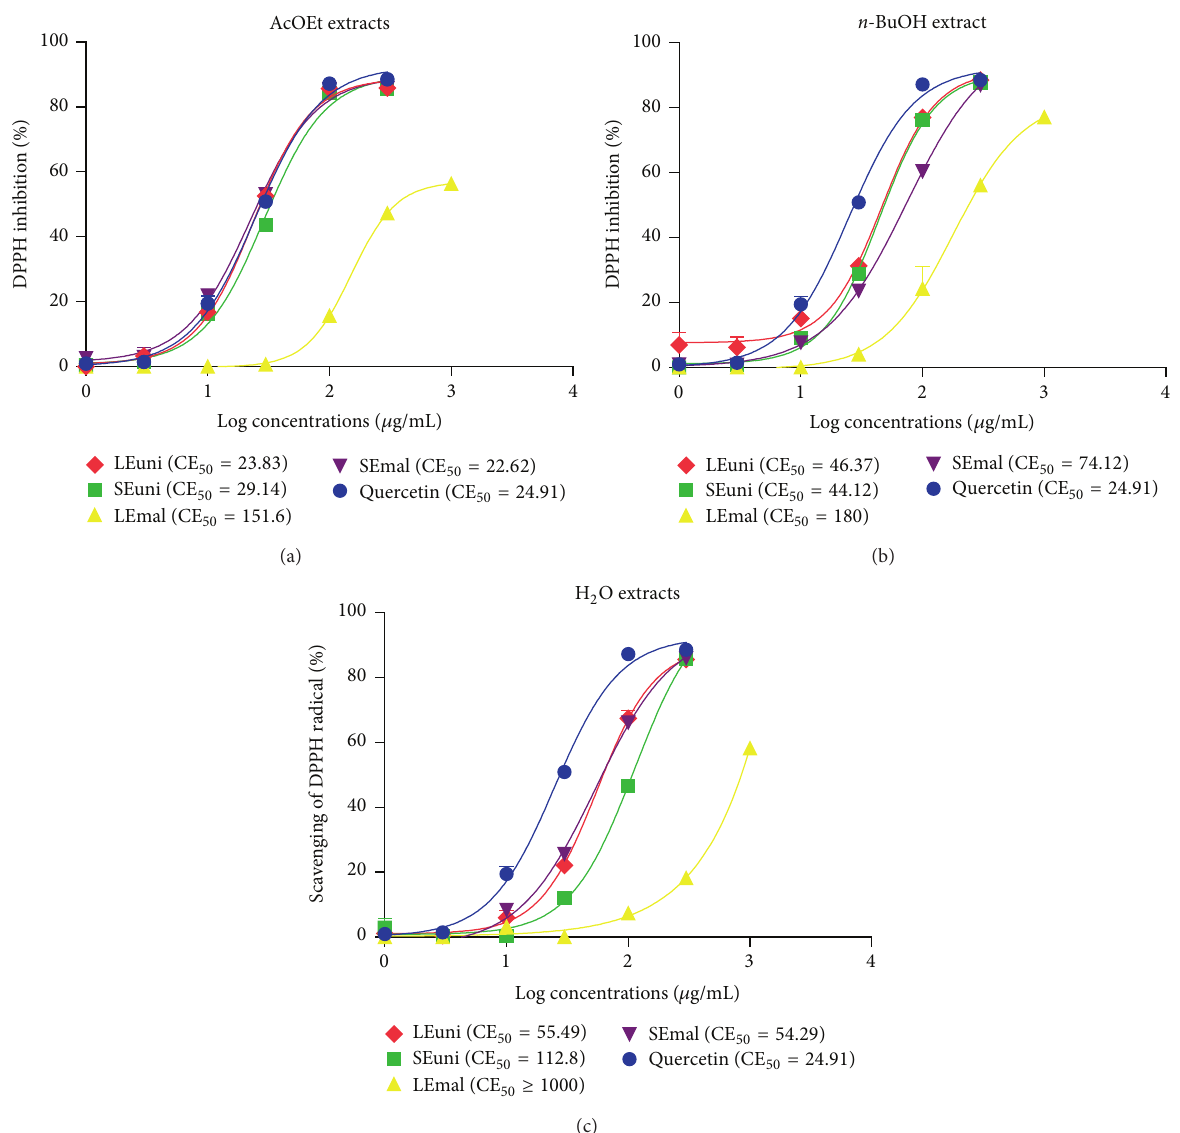
Figure 1: DPPH radical inhibition of different extracts from E. uniflora and E. malaccensis . (a) EtOAc Fr. (b) n-BuOH Fr. (c) H 2 O Fr. EC 50 is the concentration needed for 50% of inhibition. The values are represented as mean ± SD ( 𝑛 = 3 ). Leaves E. uniflora (LEuni), seeds E. uniflora (SEuni), leaves E. malaccensis (LEmal), and seeds E. malaccensis